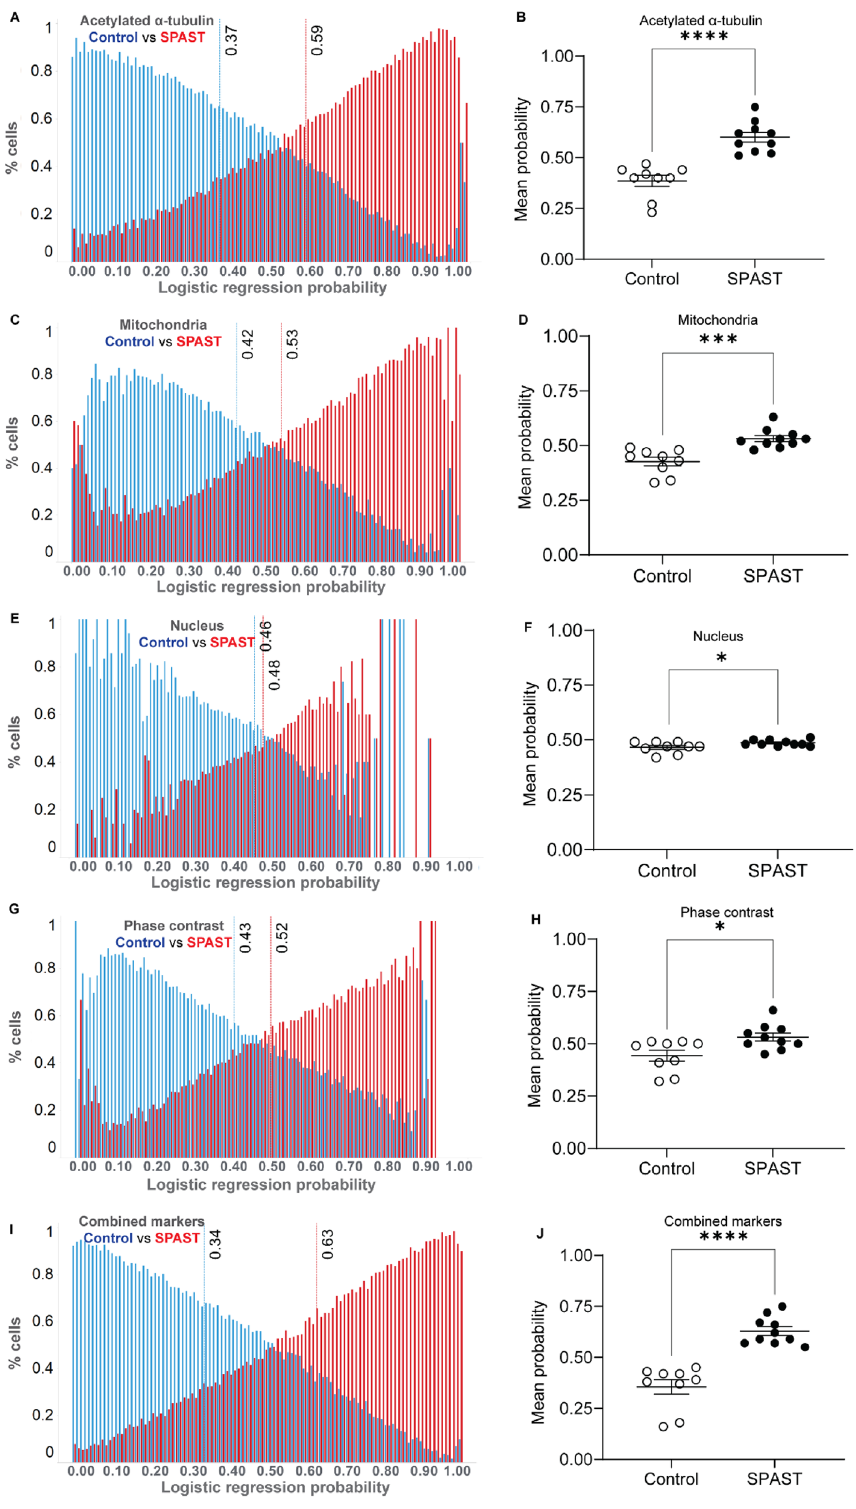
Figure 3. Logistic regression analysis of SPAST patient vs control samples. Histogram of single cell logistic regression probability scores is presented for 71,942 cells from 10 SPAST patient and 9 control individuals for multiple cell components: acetylated α-tubulin ( A ), mitochondria ( C ), nucleus ( E ), cell phase contrast ( G ) and combined markers ( I ). Dotted lines indicate mean probability score values. The mean logistic regression probability score showing all the individual patient and control cell lines is presented for acetylated α-tubulin ( B ), mitochondria ( D ), nucleus ( F ), the cell phase contrast image ( H ) and combined markers ( J ). Mean values were compared using students